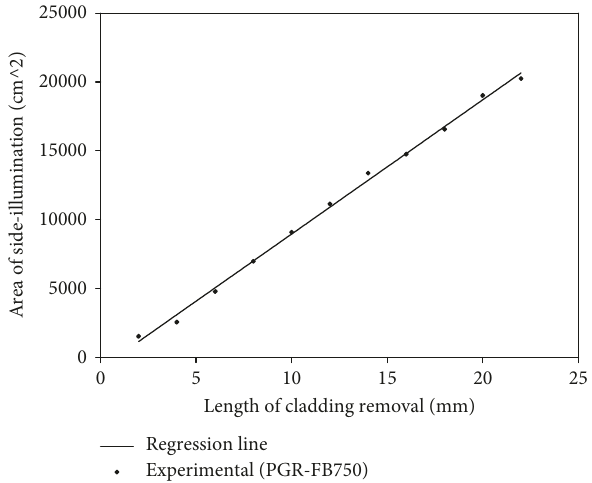
Figure 13: Effect of cladding removal length for uncrimped